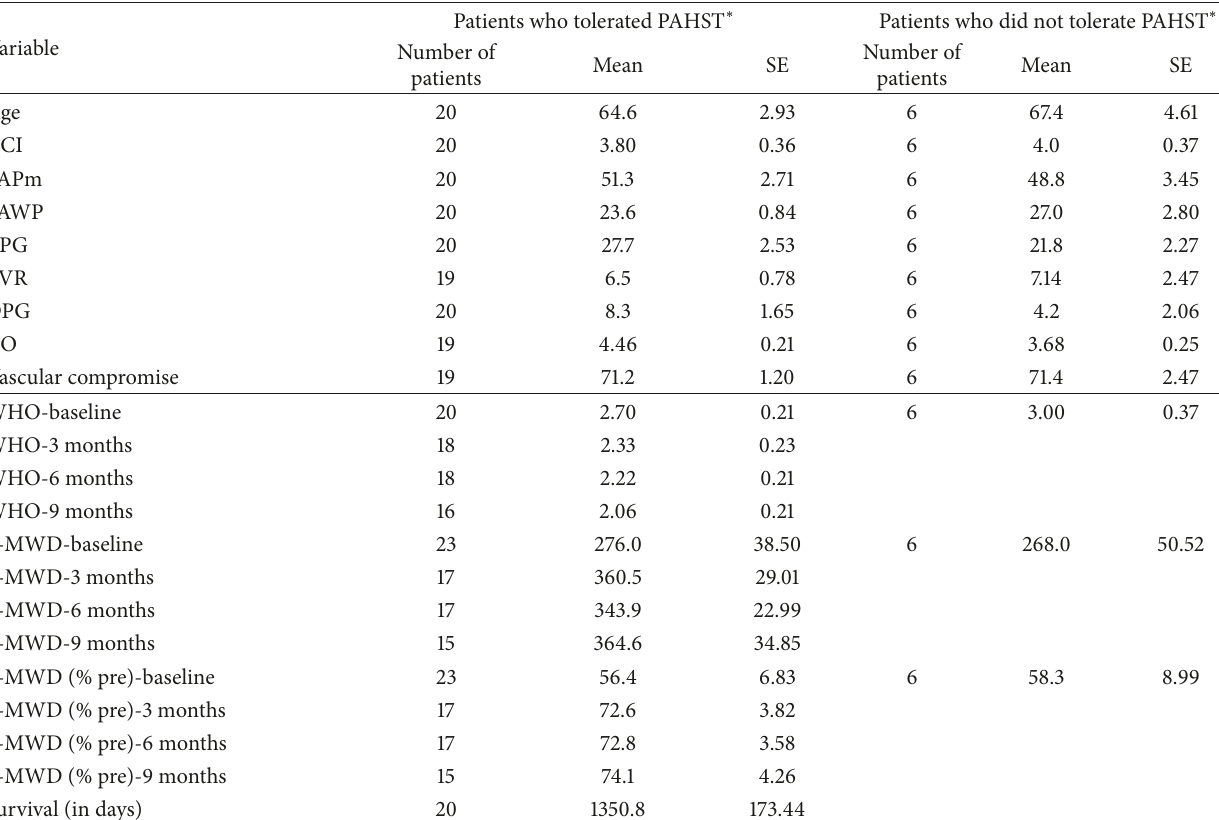
Table 1: Descriptive statistics of patients enrolled in the